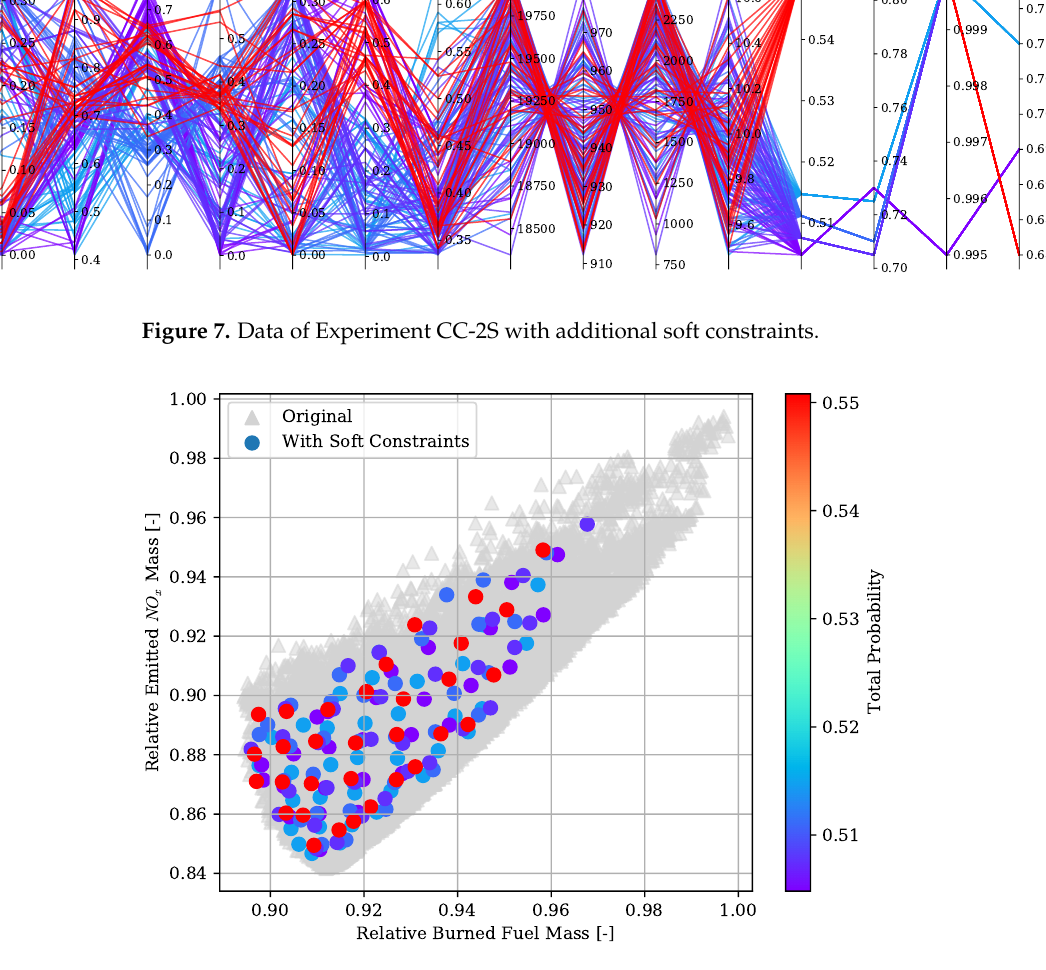
Figure 8. Objective space of data from Figures 6 and